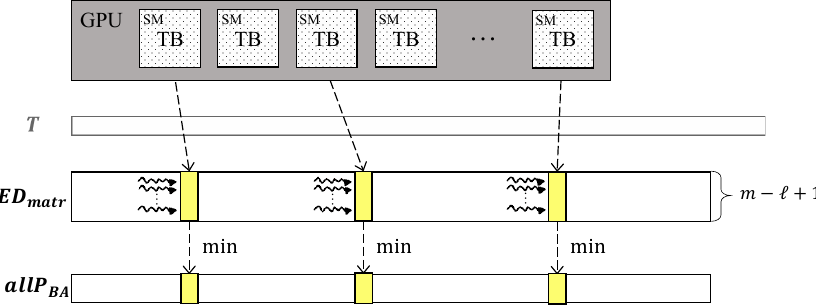
Figure 2. CUDA kernel to compute allP BA (hereinafter in figures: SM—streaming multiprocessor, TB— thread